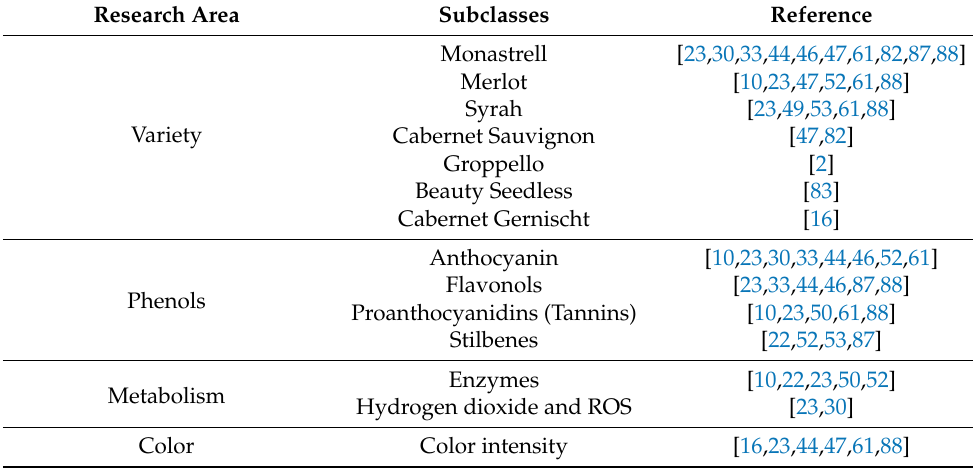
Table 1. Summary of literature on BTH impact on grape variety, phenols, color, and